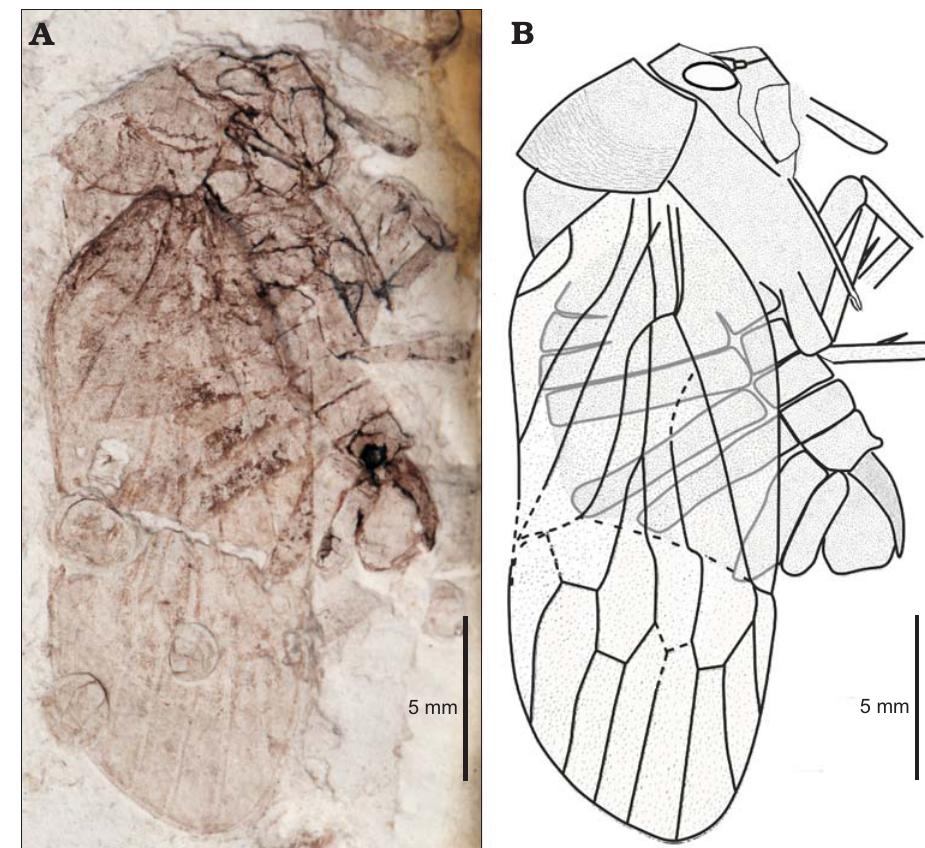
Fig. 3. Hairy cicada Sanmai mengi sp. nov., holotype (STMN48-1802) from the upper Middle–lower Upper Jurassic Daohugou beds. Photograph ( A ), explan- atory drawing ( B